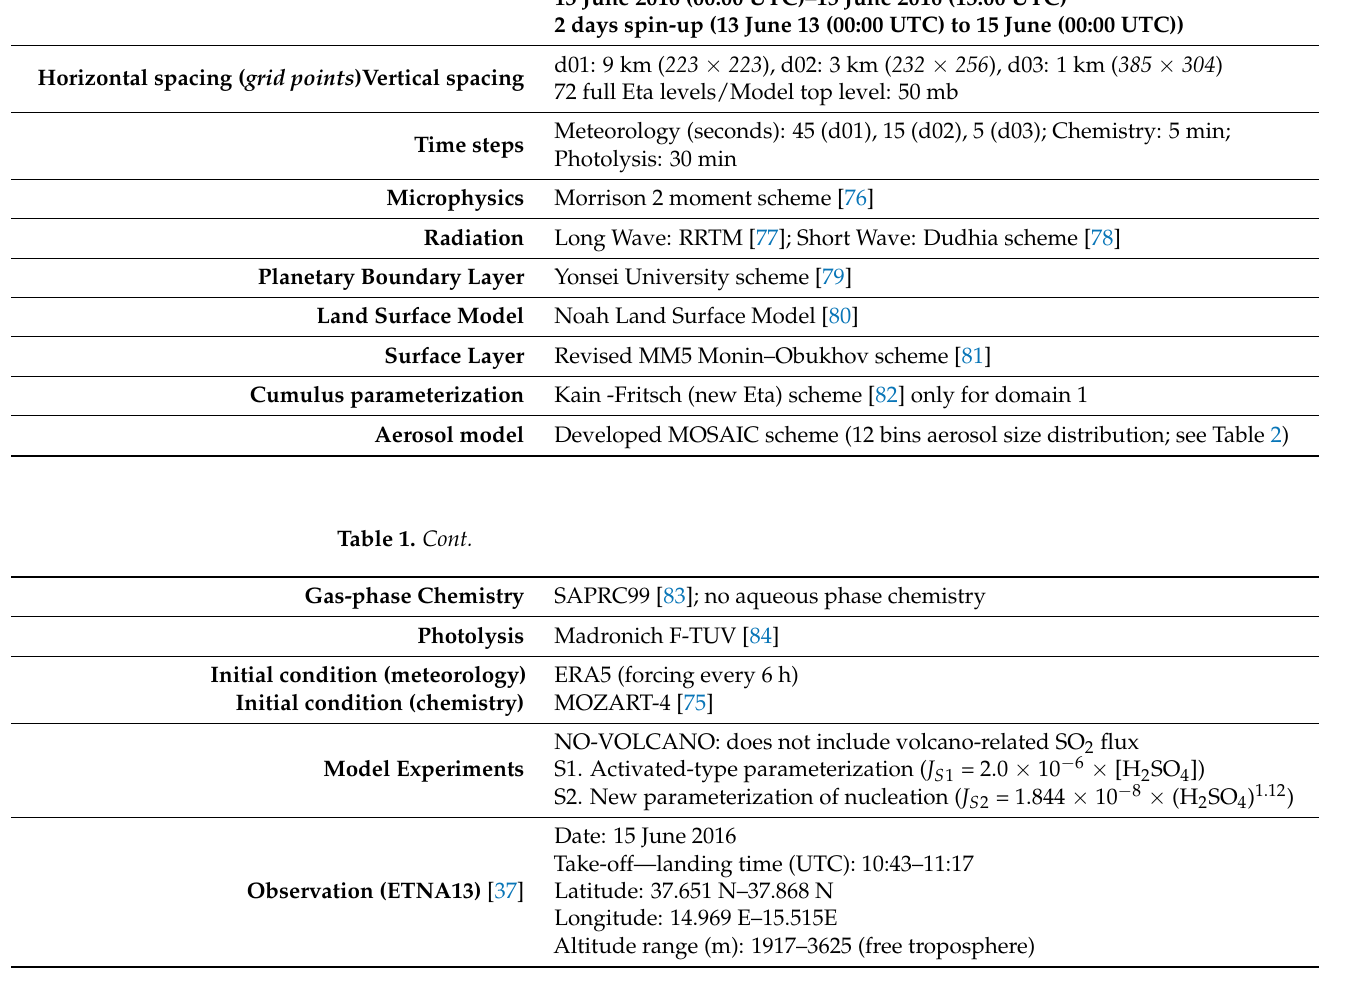
Table 2. The 12 modified sectional aerosol bins (1 nm–10 µ m) in the MOSAIC scheme in WRF-Chem, and the size distribution of available observations (flight ETNA13); dp refers to particles’ diameter. The size ranges indicated in bold are used for the model